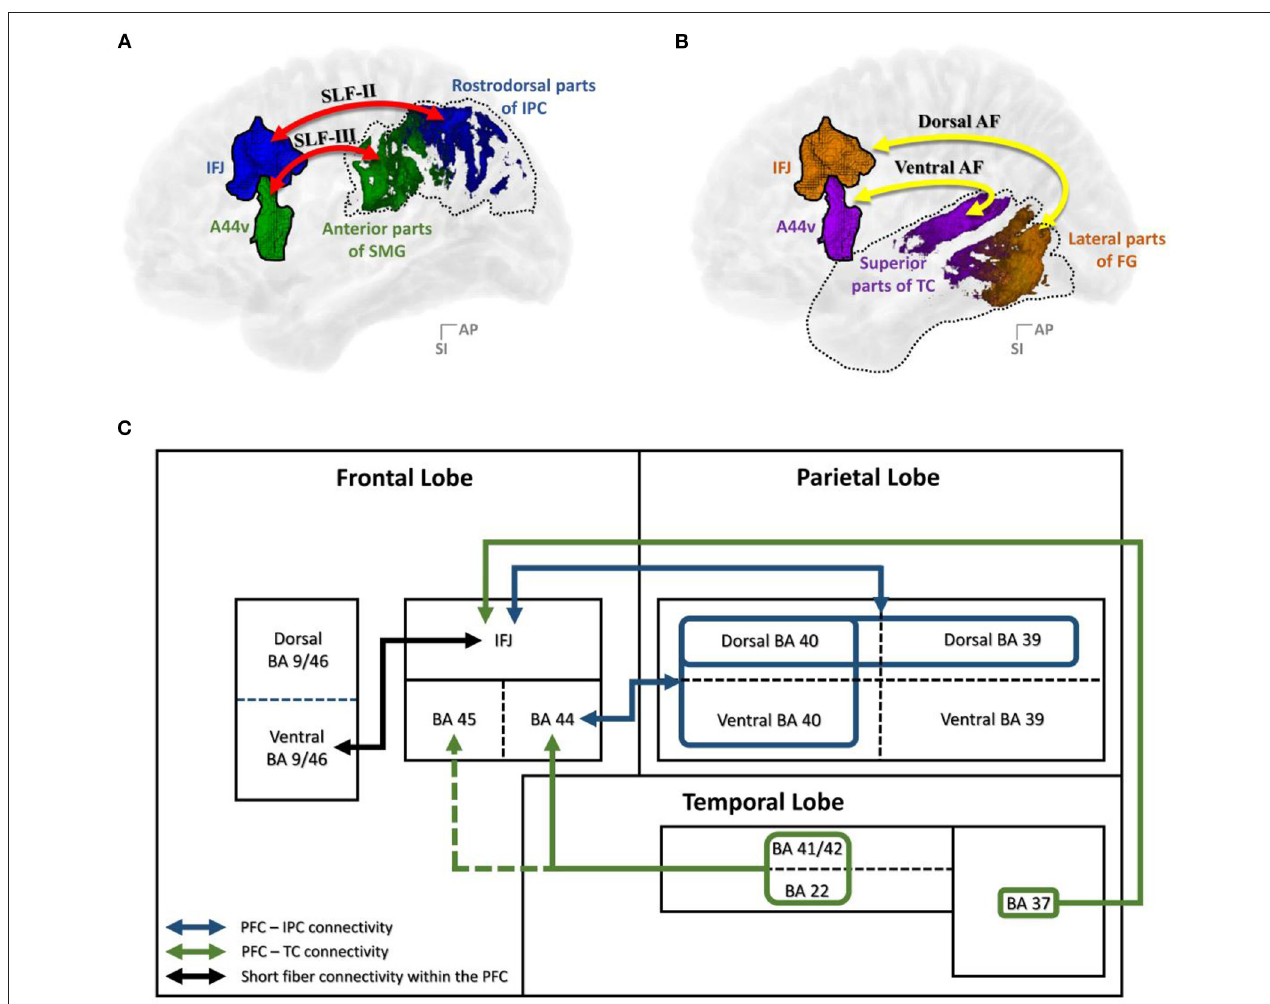
FIGURE 9 | Summary of the results: (A) PFC–IPC connectivity; (B) PFC–TC connectivity; (C) A block diagram of the structural connectivity of the dorsal language pathway. A44v, ventral area of BA44; AF, arcuate fasciculus; AG, angular gyrus; DLPFC, dorsolateral prefrontal cortex; FG, fusiform gyrus; IFJ, inferior frontal junction; IPC, inferior parietal cortex; PFC, prefrontal cortex; SLF, superior longitudinal fasciculus; SMG, supramarginal gyrus; TC, temporal